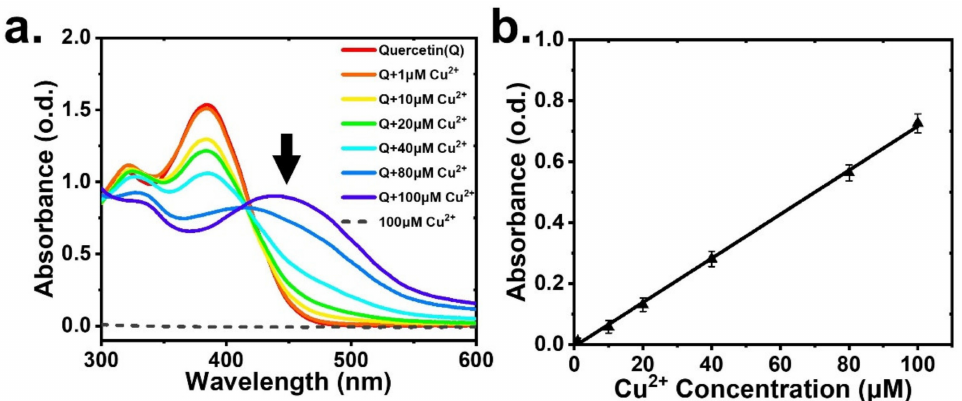
Figure 2. ( a ) UV–Vis absorption spectra of quercetin and various concentrations of Cu 2+ in 1X PBS showing two peaks at 380 nm and 450 nm, and ( b ) the absorbance as a function of Cu 2+ concentration at 450